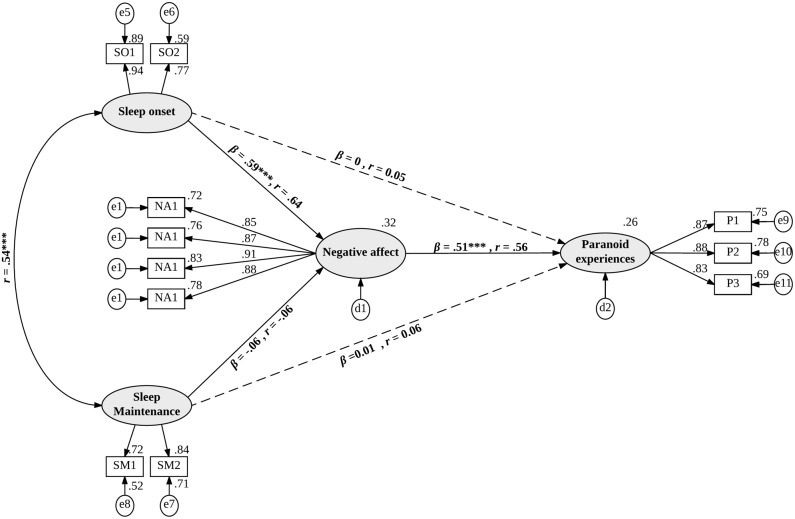
A partially and fully mediated model of the relationship between problems sleeping and paranoid thinking with factor loadings and standardized regression weights.Note: e = error, d = disturbance, SO = sleep onset, SM = sleep maintenance, NA = negative affect. P = paranoia. Rectangular boxes represent indicator variables (e.g., survey responses) which have been parcelled together to form an average (e.g., SO1 and SO2 are parcels consisting of items representing sleep onset), ovals represent latent variables while circles represent error or disturbance. Solid lines represent a fully mediated model; while the addition of the two dashed lines form a partially mediated model.